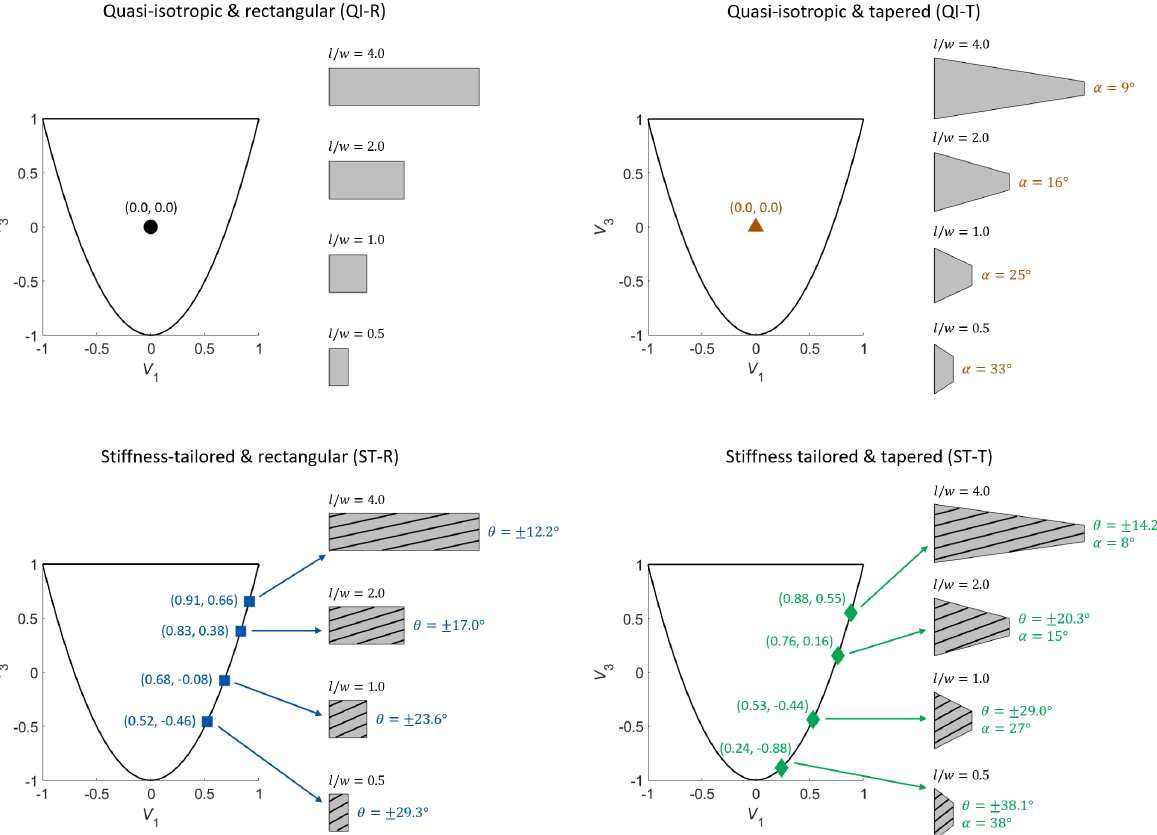
Figure 4. Optimal lamination parameters with corresponding layer angles and taper angles for different design approaches and aspect ratios.